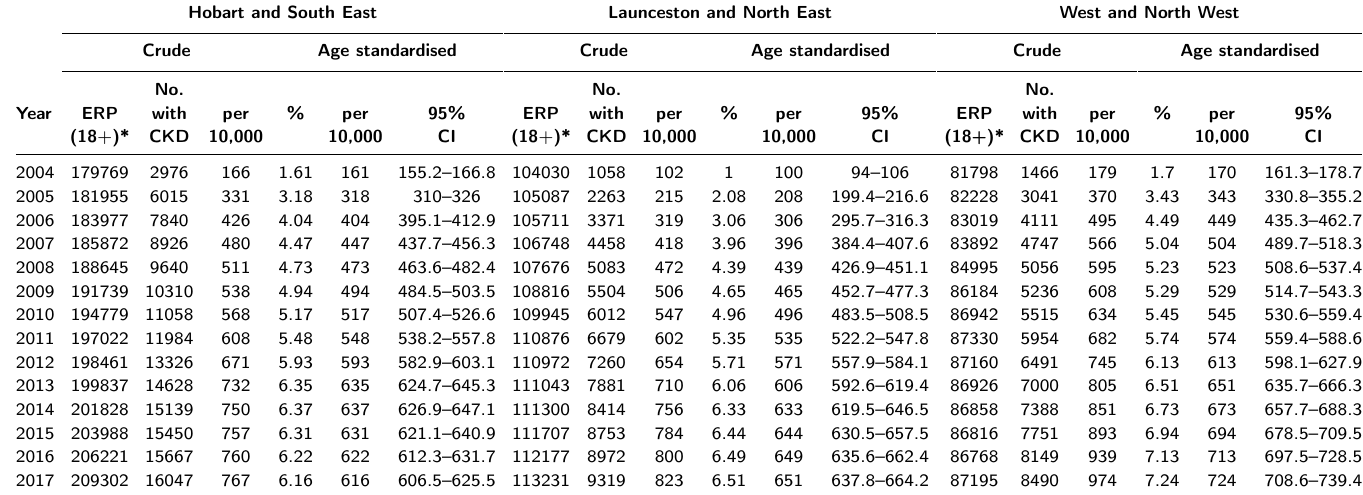
Supplementary table 3: Prevalence of chronic kidney disease in Tasmania by geographical region